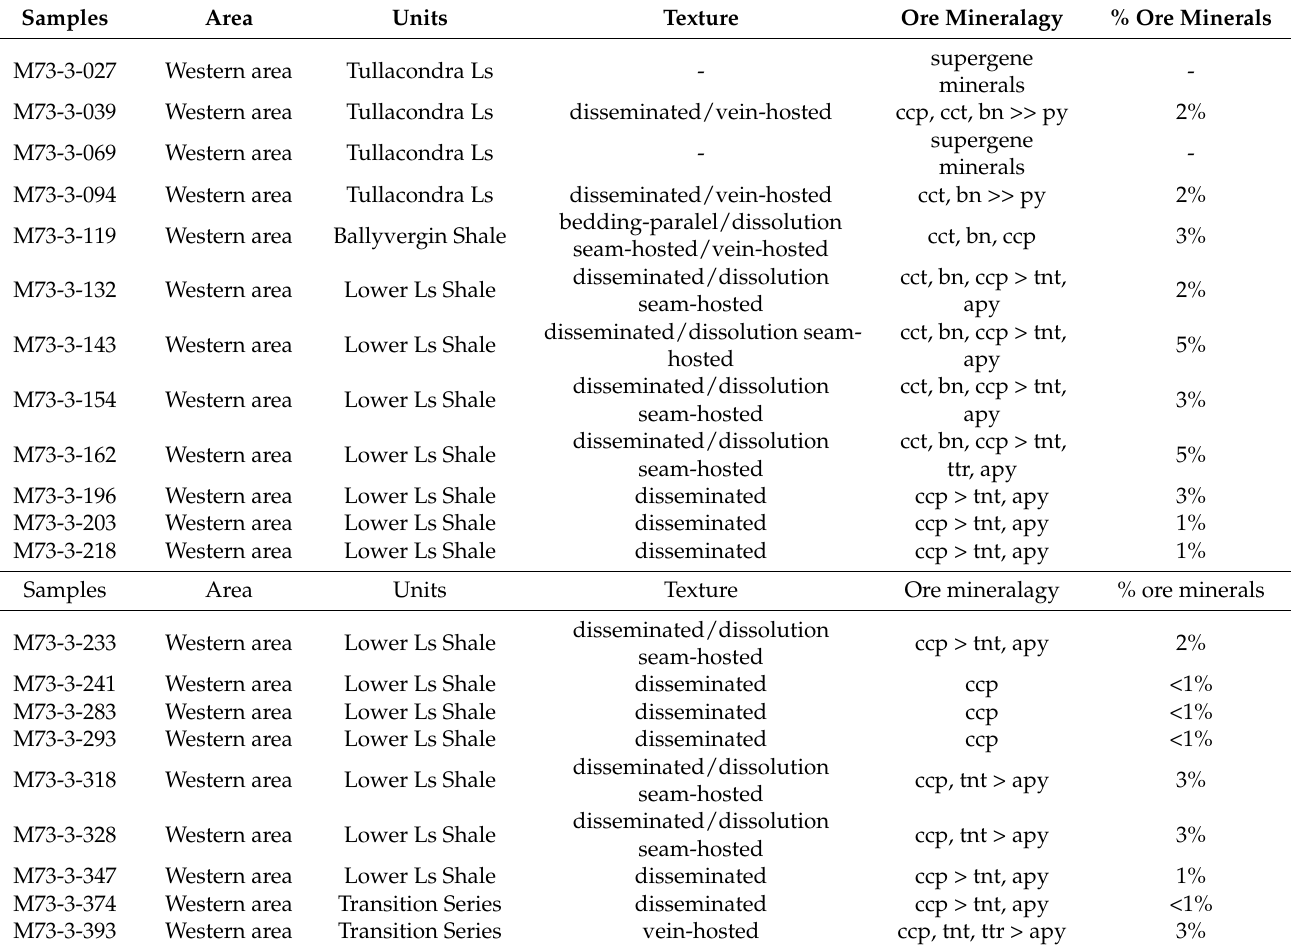
Table A2. Texture and ore